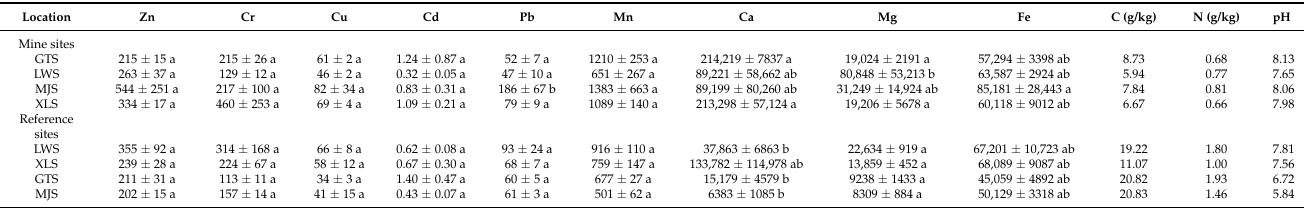
Figure 2. Photographs detailing the local site conditions: ( a ) MJS mine site, ( b ) GTS reference site, ( c ) MJS mine site vegetation in spring, ( d ) MJS mine site vegetation in autumn, ( e ) GTS mine site, and ( f ) LWS mine site. Table 1. Soil properties from the sampling locations for plant diversity located around Zhenjiang (all values are total content in mg/kg, except for total carbon and nitrogen in g/kg). The soil was sampled at 10–30 cm depth. Metal concentration values are means ± SD (n = 3). Different lowercase letters represent significant differences at the location × site level ( p <